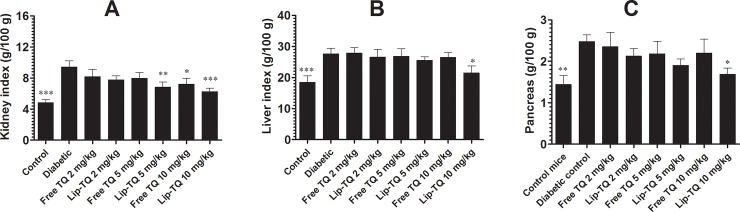
Treatment with Lip-TQ improves the organ index in C. albicans infected diabetic mice.On day 4 post-treatment, the kidney, pancreas and liver were taken from the mice of various groups and were washed in PBS. The organic index of (A) kidney, (B) liver and (C) pancreas, was calculated as follows: organ weight / body weight. Data are expressed as mean ± SD from organs three different mice. A P value <0.05 was considered to be significant.